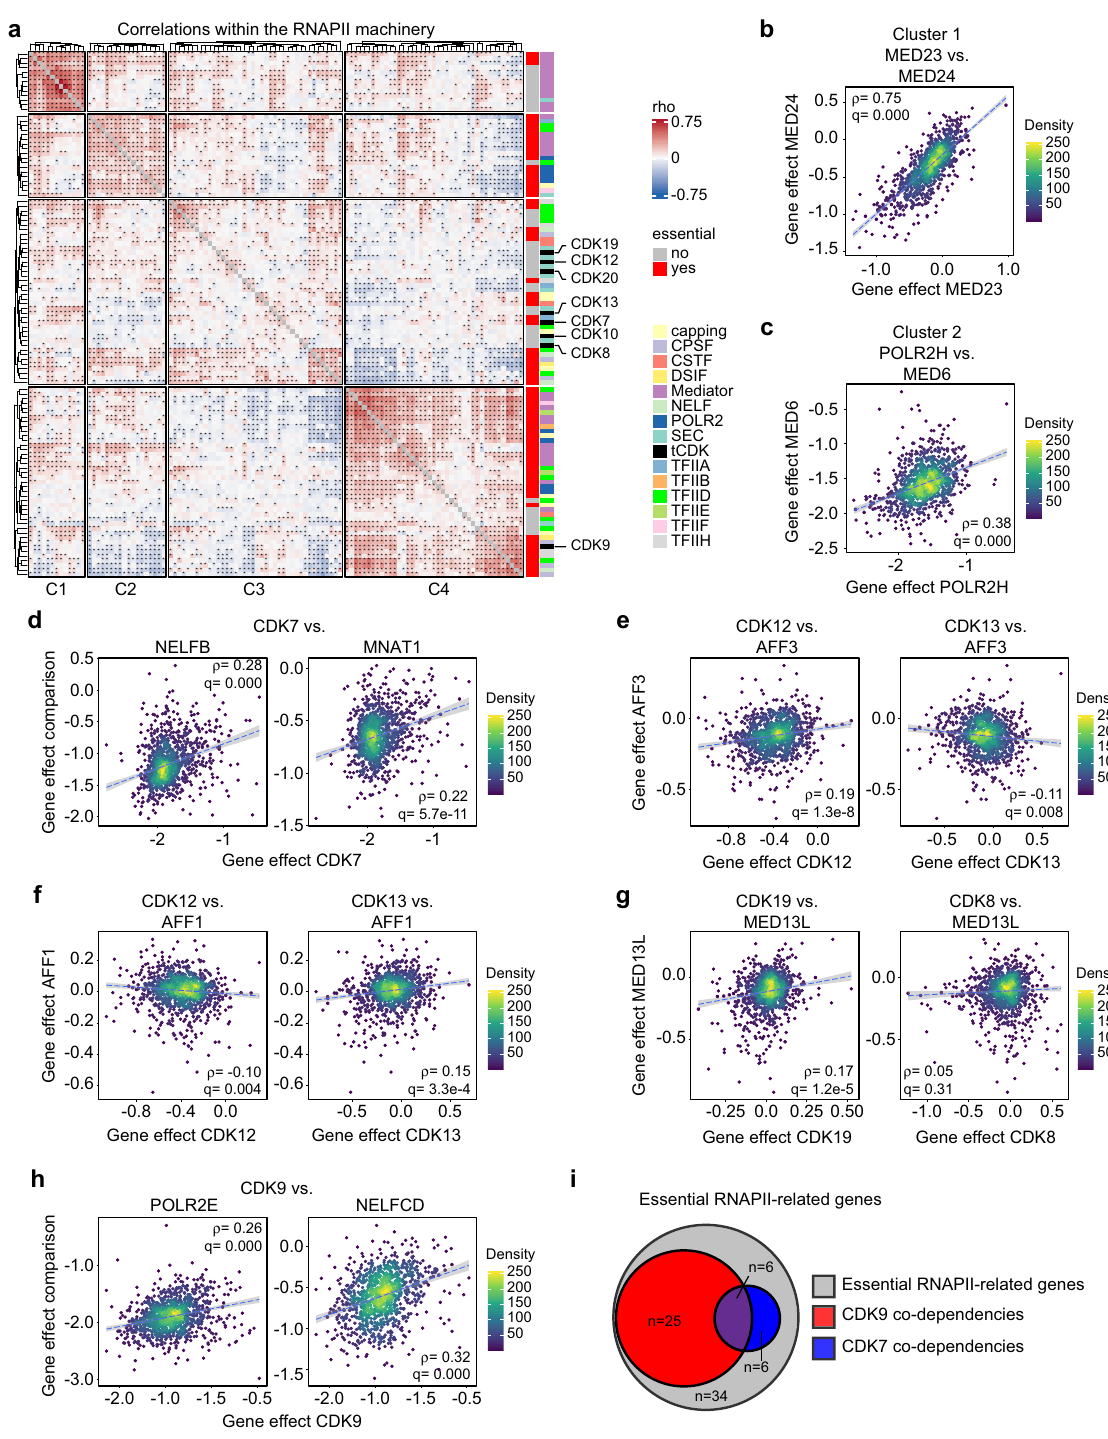
Figure 3. tCDKs exhibit differential genetic co-dependencies with the RNAPII machinery. ( a ) Heatmap depicting gene effect correlations between tCDKs and various genes involved in RNAPII-dependent transcription. Asterisks denote significant (FDR < 0.1). Essential genes (red, right-side annotation) are determined by median gene effect scores of < − 0.5 across all cell lines. In the multi color-coded annotation to the right of the heatmap, colors indicate diverse protein complexes. Dendrograms represent results from unsupervised clustering analysis. ( b ) Scatter plot comparing gene effect scores of MED23 and MED24 across all 1070 cell lines in the DepMap data set. ( c ) Scatter plot comparing gene effect scores of POLR2H and MED6 across all 1070 cell lines in the DepMap data set. ( d ) Scatter plot comparing gene effect scores of CDK7 to NELFB and MNAT1 across all 1070 cell lines in the DepMap data set. ( e ) Scatter plot comparing gene effect scores of CDK12 and CDK13 to AFF3 across all 1070 cell lines in the DepMap data set. ( f ) Scatter plot comparing gene effect scores of CDK12 and CDK13 to AFF1 across all 1070 cell lines in the DepMap data set. ( g ) Scatter plot comparing gene effect scores of CDK8 and CDK19 to MED13L across all 1070 cell lines in the DepMap data set. ( h ) Scatter plot comparing gene effect scores of CDK9 to POLR2E and NELFCD across all 1070 cell lines in the DepMap data set. ( i ) Venn diagram comparing significant positive co-dependencies (rho > 0, FDR < 0.1) of CDK7 and CDK9 among essential (median gene effect < − 0.5) transcription-related genes shown in ( a